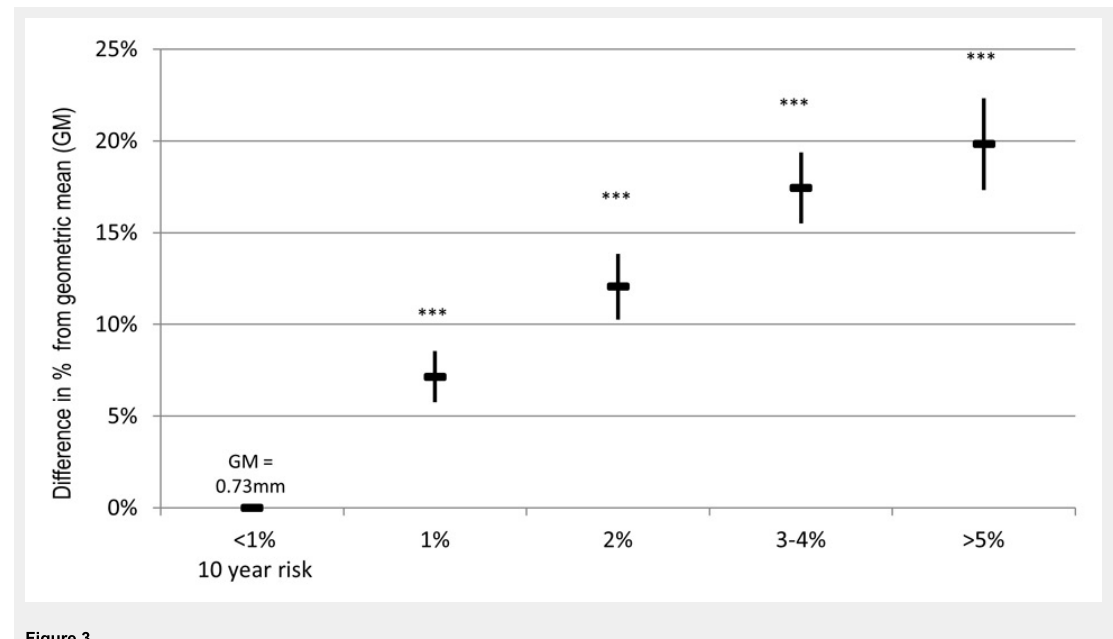
Figure 3 Association of SCORE with aCIMT in SAPALDIA 3. ▬ Depicts estimated %difference of the geometric mean (GM), ▌ confidence interval of estimated % change. *** p-value <0.001, between risk and reference category, α adjusted for study area (random effect)